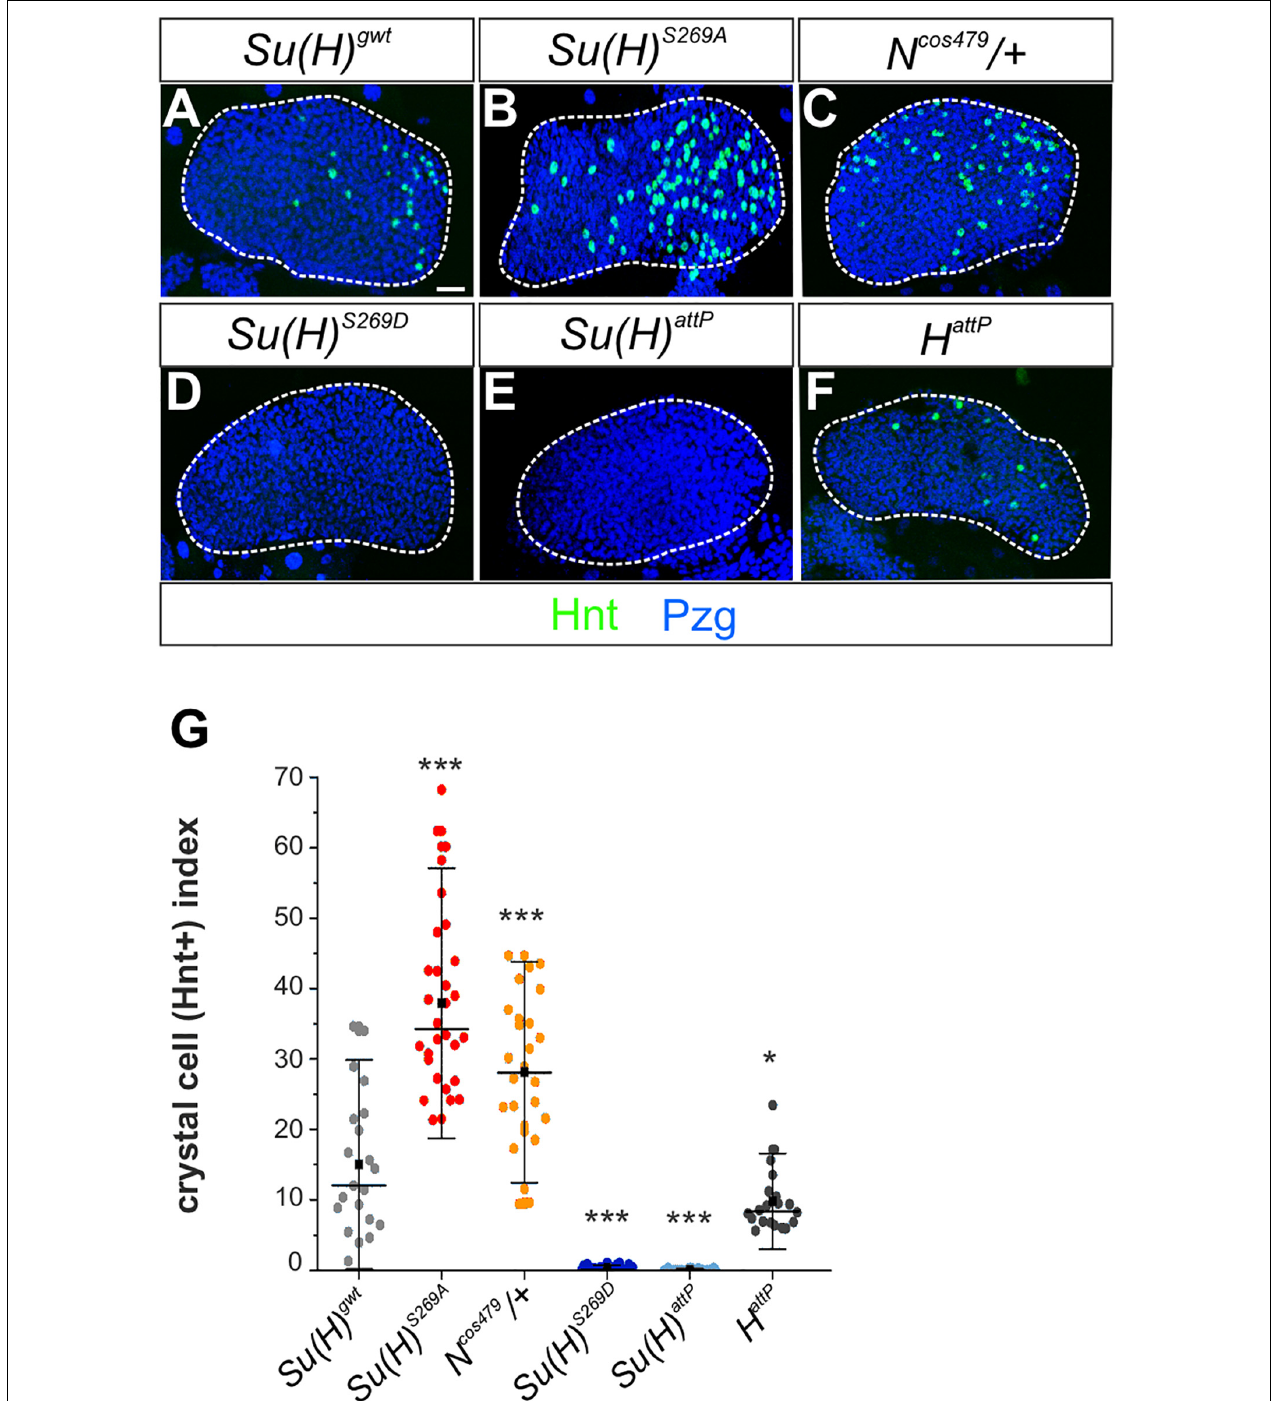
FIGURE 5 | N-dependent lymph gland development is responsive to Su(H) phospho-site mutations. (A–F) Shown are primary lobes of third instar larval lymph glands stained with anti-Hnt (green) and anti-Pzg (blue). Crystal cell numbers were altered in Su(H) phospho-site mutant lymph glands relative to the control (A,C,D) . N cos 479 / + (B) and Su(H) attP (E) were used for comparison to reflect a Notch gain- and loss background, respectively. (F) Lobes from H attP mutants did not show an increased but rather a reduced number in Hnt positive cells. Scale bar represents 20 µ m for all panels. (G) Ratio of Hnt + cells per lobe relative to the lobe’s size. At least 20 lymph glands per genotype were scored. Each point represents one lobe. Mean is shown as a black square, the median is represented as horizontal bar. Error bars represent ± s.d. *** p < 0.001; * p < 0.05; ns (not significant) p > 0.05, two-tailed Dunnett’s test relative to control. Genotypes analyzed: Su(H) gwt ( n = 21), Su(H) S 269 A ( n = 30), Su(H) S 269 D ( n = 28), Su(H) attP ( n = 28), N cos 479 / + ( n = 26), H attP ( n = 20).